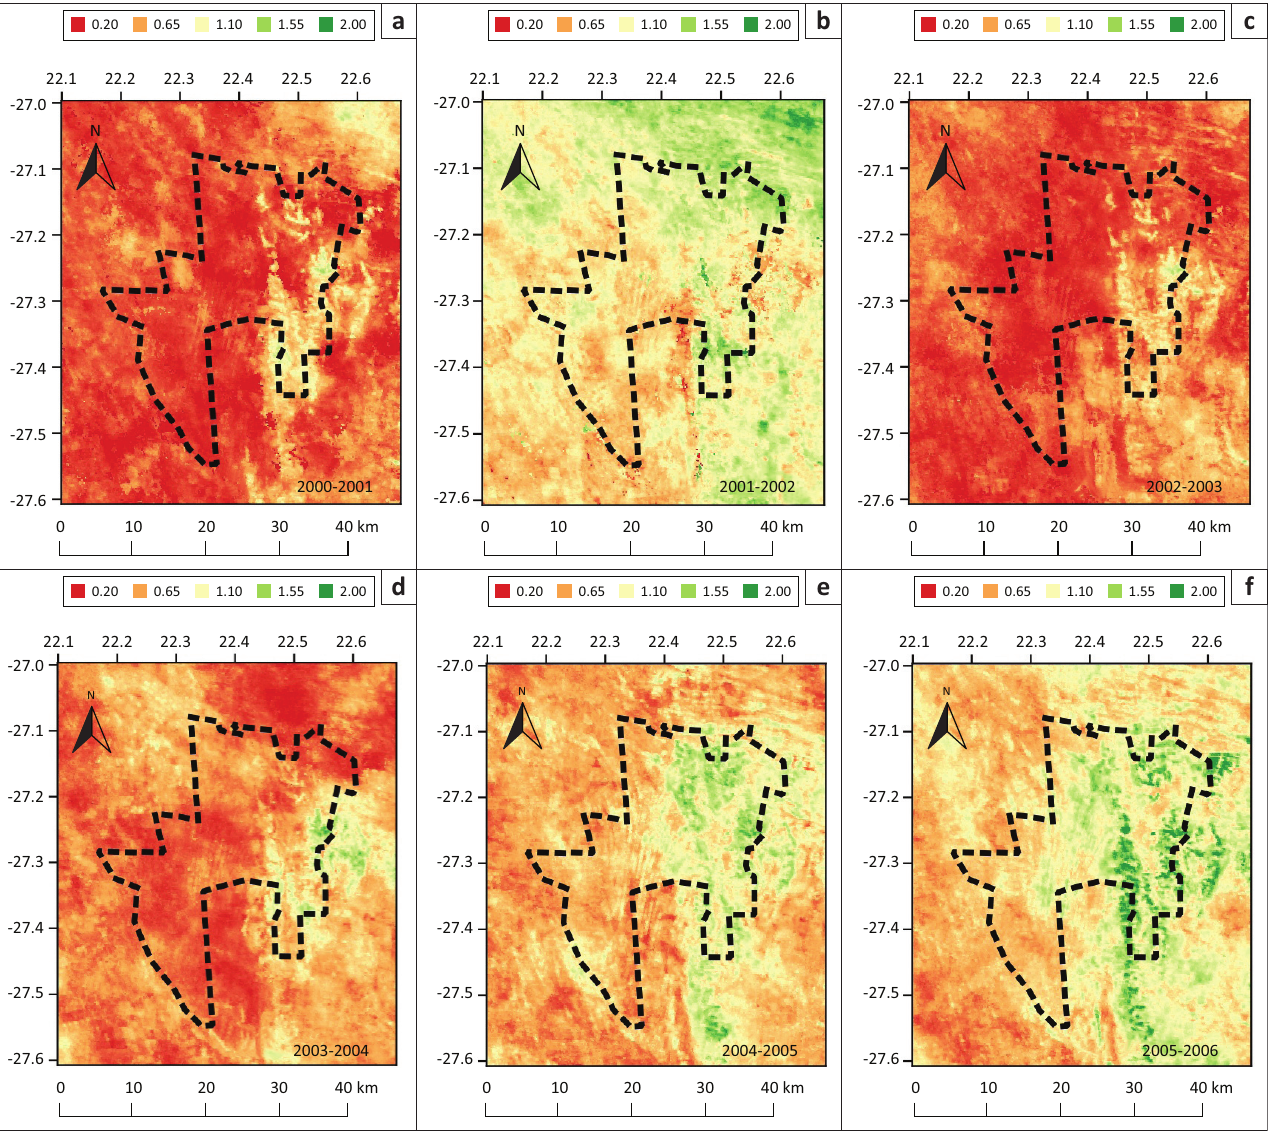
FIGURE 2: A composite image of the annual small integrated value of the Enhanced Vegetation Index in the Tswalu Kalahari Reserve for the 2000–2001 to 2014–2015 growth season, which starts at the beginning of October and ends at the end of September. Red colours indicate a lower Enhanced Vegetation Index value corresponding to lower plant productivity. (a) 2000–2001, (b) 2001–2002, (c) 2002–2003, (d) 2003–2004, (e) 2004–2005, (f) 2005–2006, (g) 2006–2007, (h) 2007–2008, (i) 2008–2009, (j) 2009–2010, (k) 2010–2011, (l) 2011–2012, (m) 2012–2013, (n) 2013–2014 and (o) 2014–2015.